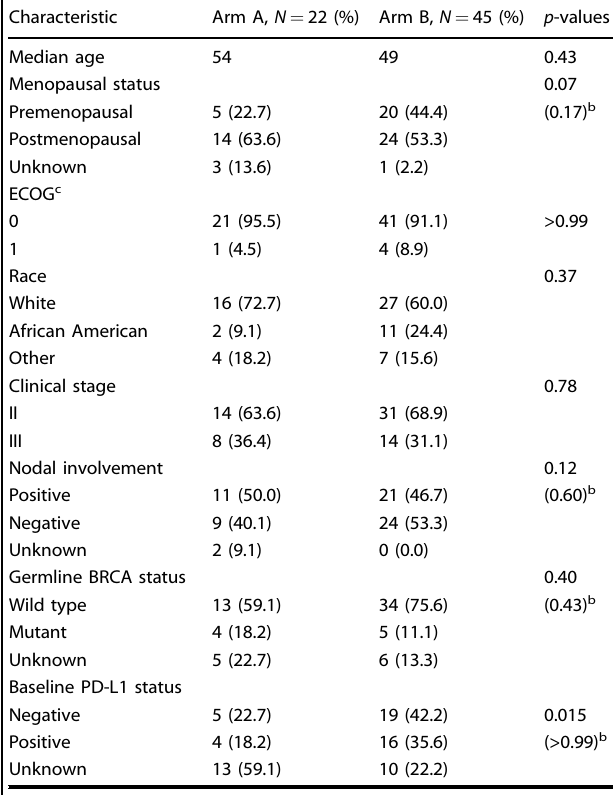
Table 1. Baseline patient characteristics a